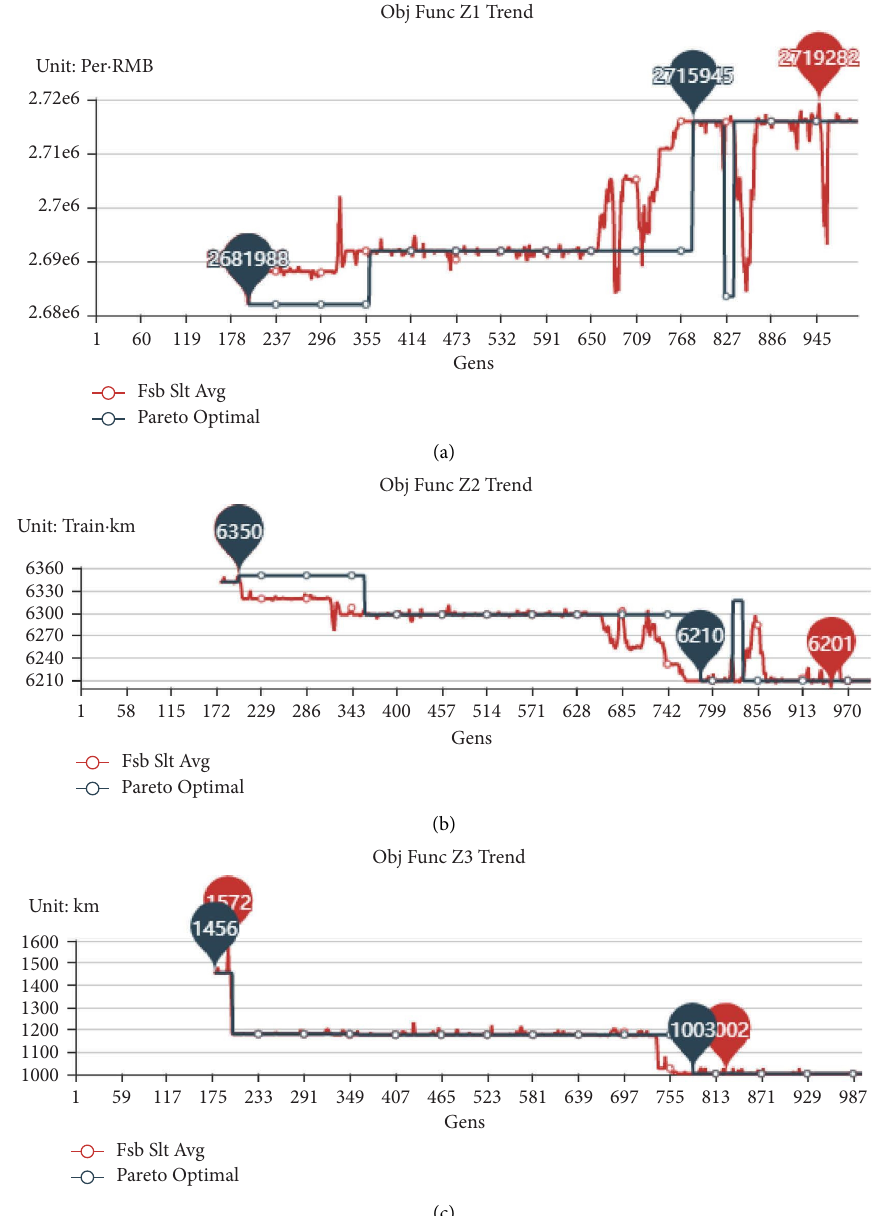
Figure 8: Trend of 3 objective functions: (a) Trend of objective function Z1, (b) trend of objective function Z2, and (c) trend of objective function